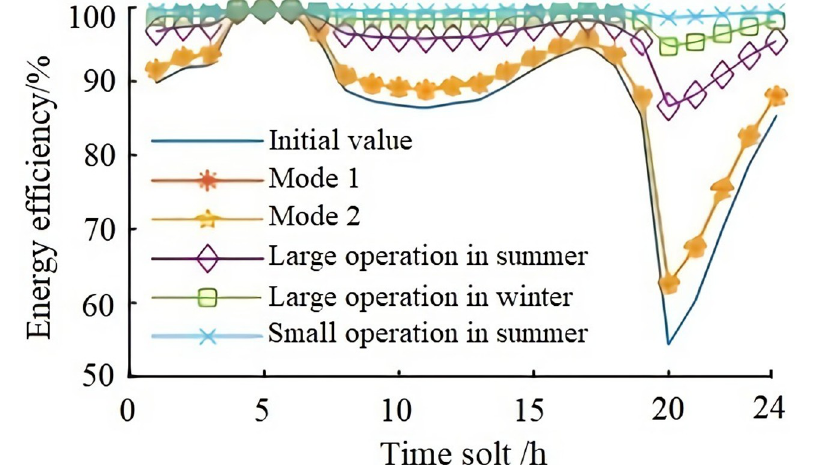
Fig 5. The trend of system comprehensive energy